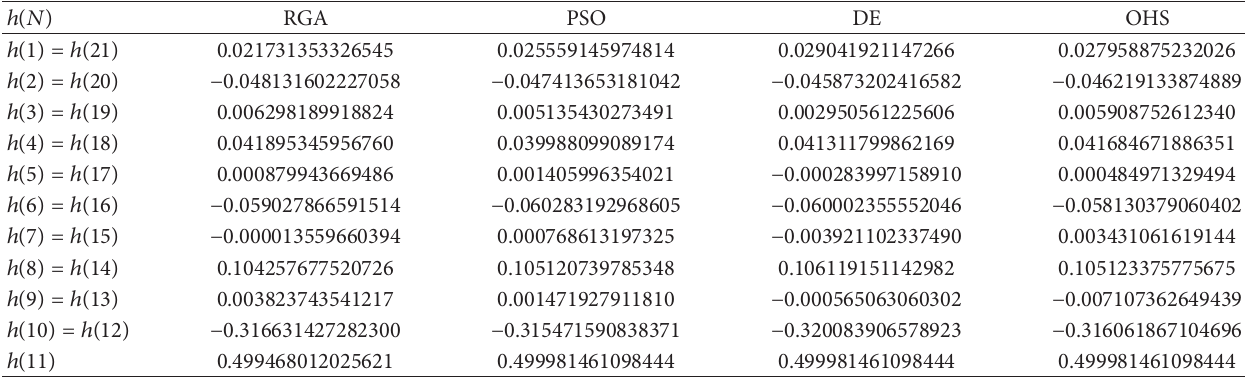
Table 3: Optimized coefficients of the FIR HP filter of order 20.